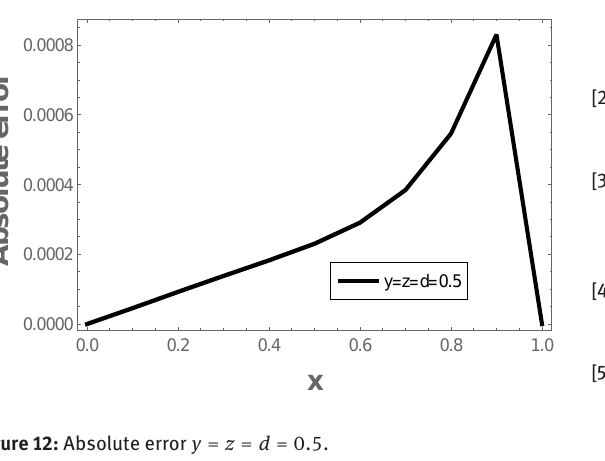
Figure 12: Absolute error y = z = d = 0.5